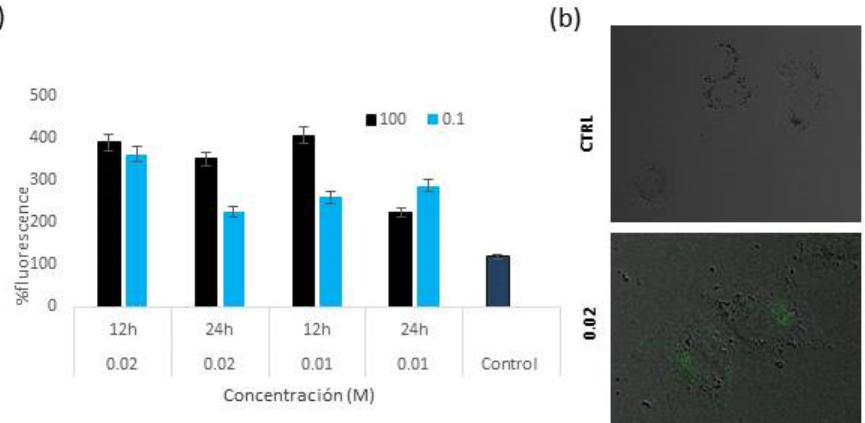
Figure 10. Uptake and intracellular localization of Tb 3+ :cit-cAp nanoparticles. ( a ) Uptake of particles prepared with x = 0.010 M and 0.020 M Tb 3+ at 100 µ g/mL and 0.1 µ g/mL at 12 h and 24 h after treatment. ( b ) Merged confocal fluorescence and phase contrast microscopy images (20 × ) of A375 cells incubated for 12 h with Tb 3+ -doped particles. Intracellular cytoplasmic uptake can be observed at 12 h after treatment with Tb 3+ containing particles ( x = 0.020 M Tb 3+ ).